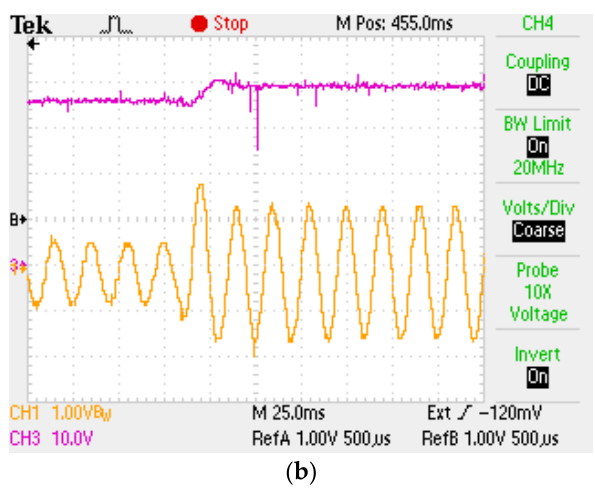
Figure 26. Time evolution of the DC-capacitor voltage and supply current during: ( a ) start-up compensation at nominal load, followed by compensation at nominal load and then compensation at reduced load by half; ( b ) compensation at reduced load (0.5 S N ) followed by compensation at nominal load ( S N ).